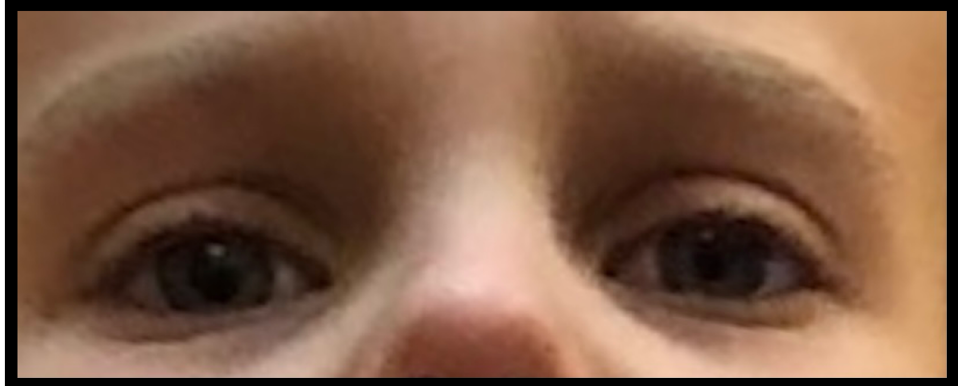
Figure 8. The child presented with full improvement after experiencing Horner’s